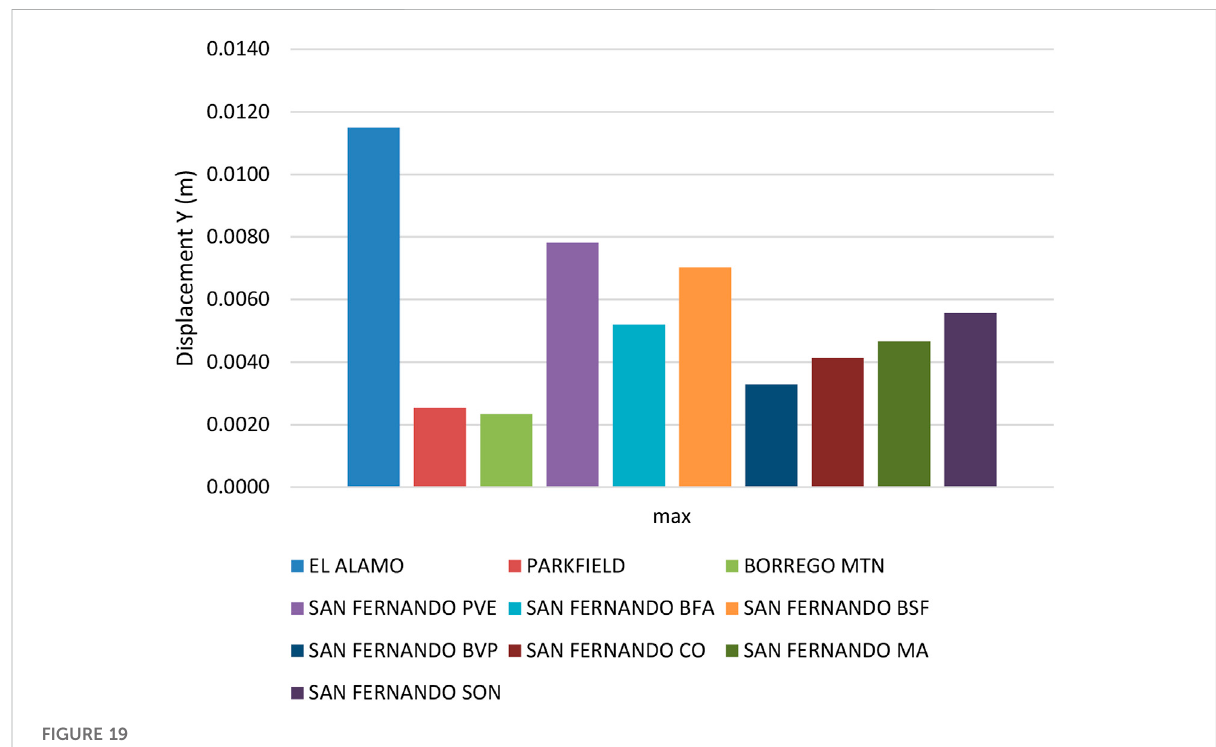
FIGURE 19 Displacement in Y.